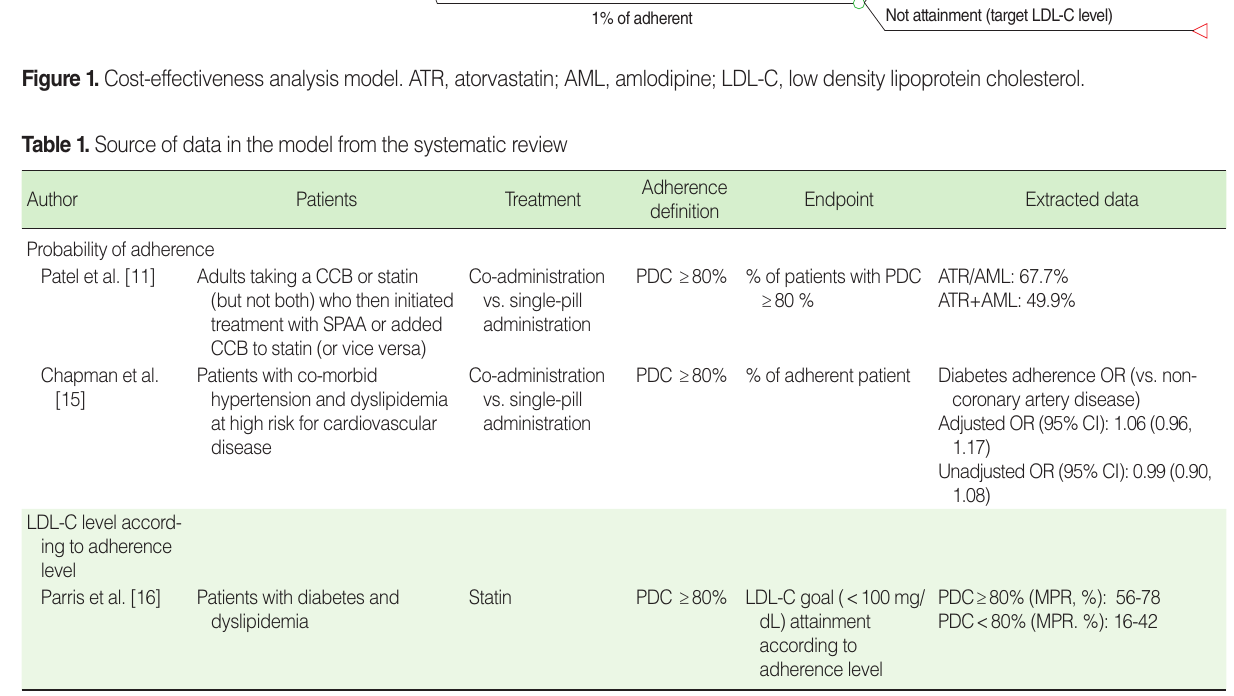
Diabetes with hypertention